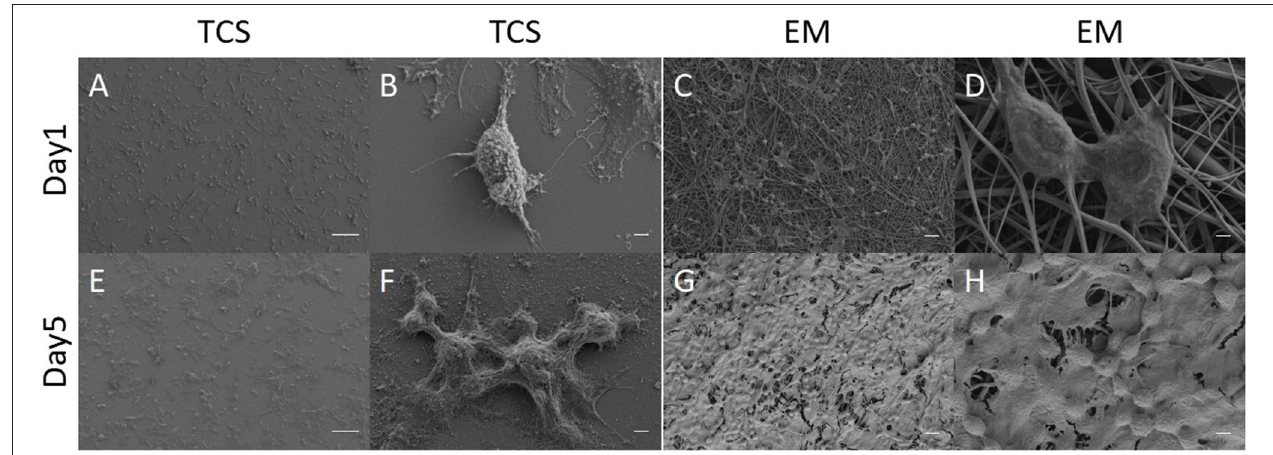
FIGURE 6 | SEM: Cell morphology of L929 grown on EM (C,D,G,H) and TCS (A,B,E,F) on day 1 and day 5. Scale bar: (A,B) 100 µ m, (B,D,F,H) 2 µ m, (C,G) 20 µ m.